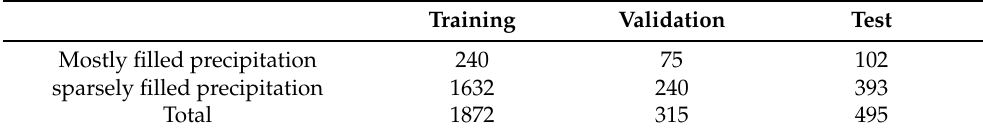
Table 1. The number of training, validation, and test scans for mostly filled precipitation and sparsely filled precipitation. Training Validation Test Mostly filled precipitation 240 75 102 sparsely filled precipitation 1632 240 393 Total 1872 315